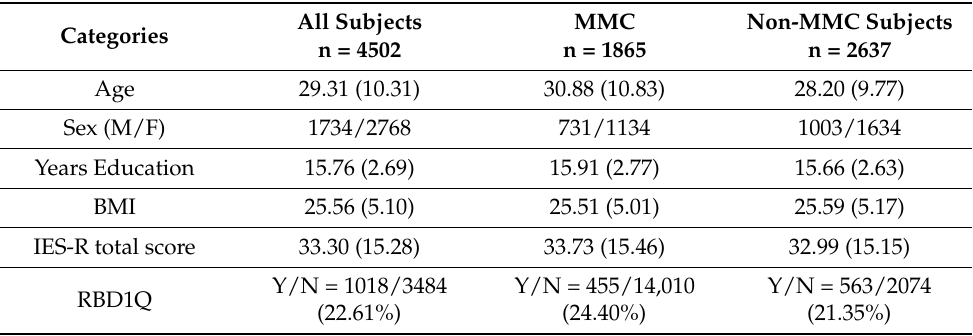
Table 1. Demographics in the 4502 participants: all subjects, Metropolitan Mexico City, and non- Metropolitan Mexico City subjects. Data in Mean